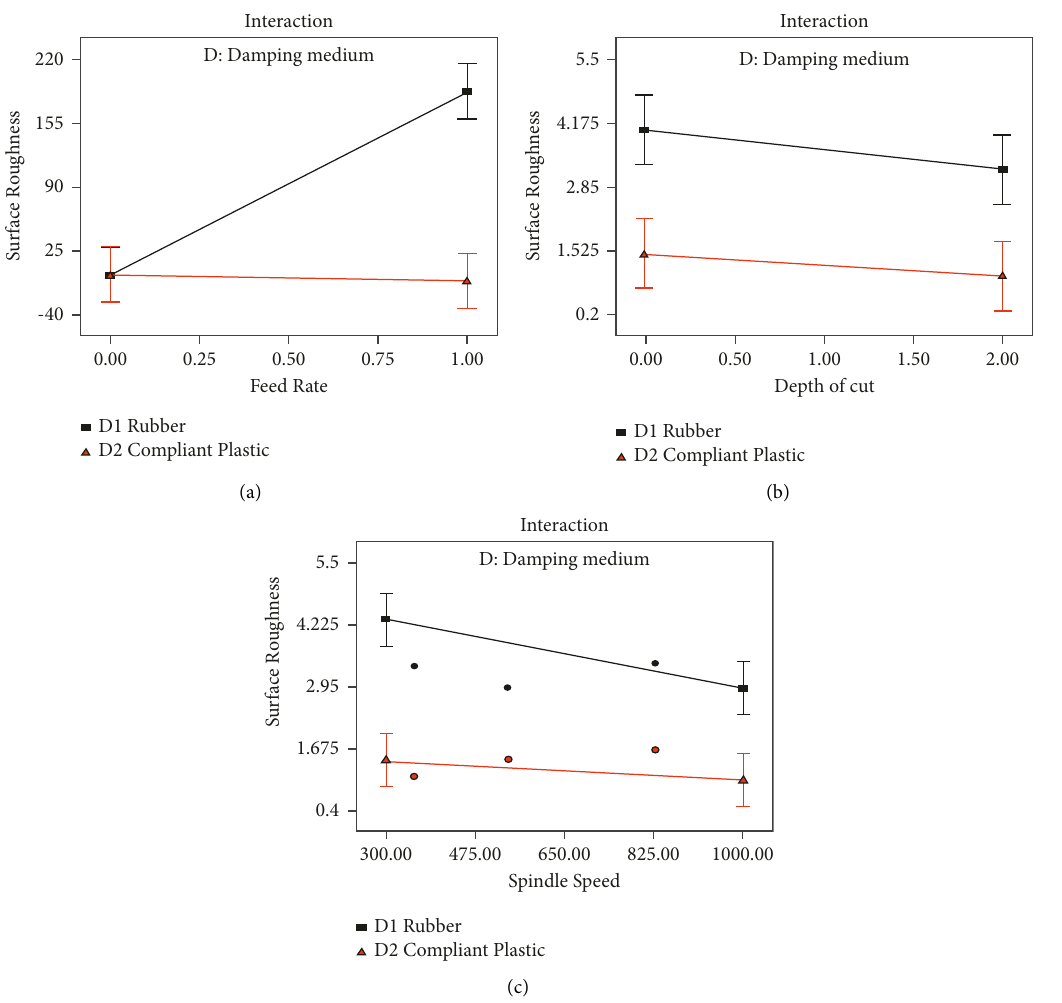
Figure 10: Interaction plots for surface roughness with machining parameters: (a) surface roughness vs. feed rate, (b) surface roughness vs. depth of cut, and (c) surface roughness vs. spindle